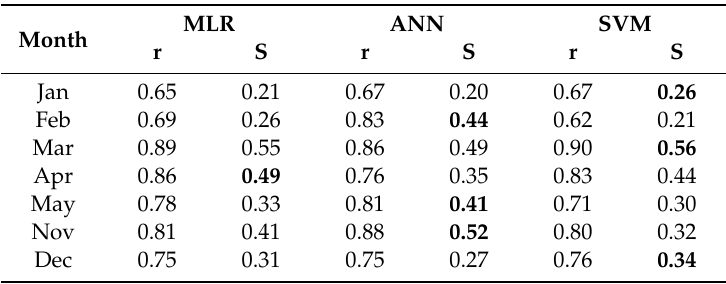
Table 5. Monthly forecast skill scores (r and S) between the observed and predicted dam inflow with a 3-months lead time. The bold numbers represent the best prediction skill score of each